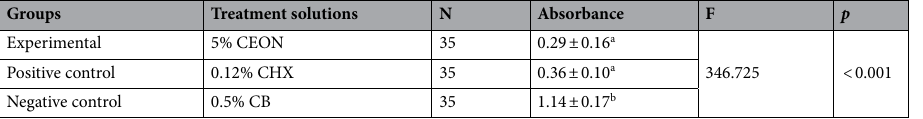
Table 3. Absorbance of oral bacterial suspensions according to treatment solution. CEON cinnamon essential oil nanoemulsion, CHX chlorhexidine gluconate, CB cocamidopropyl betaine. p value obtained from one- way analysis of variance. All values are expressed as means ± standard deviations. a, b Different letters indicate significance by Scheffe’s multiple comparison test at α =